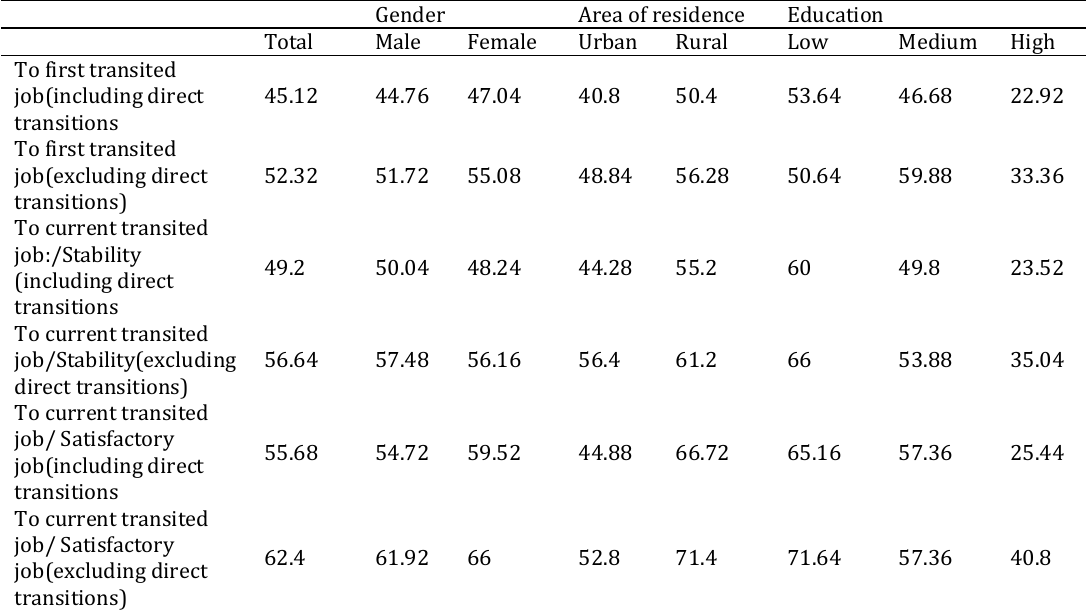
Table 7: Average lengths of labor market transitions from school graduation by gender, residence area, and by education status (months)